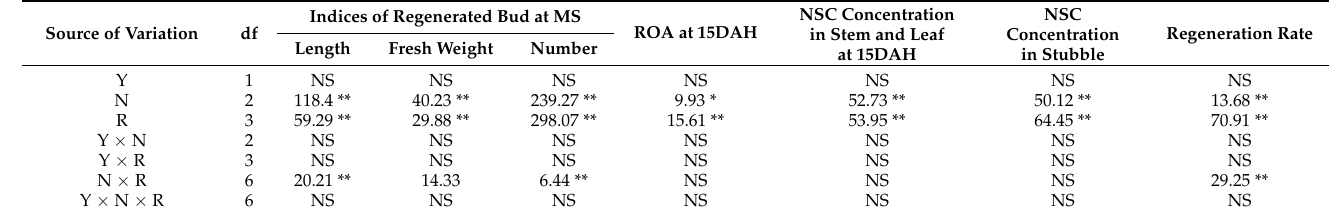
Table 3. Analysis-of-variance of F-values of key indices such as the growth and development of the main crop after full heading, growth of regenerative bud, and regenerative ability between/among years, N